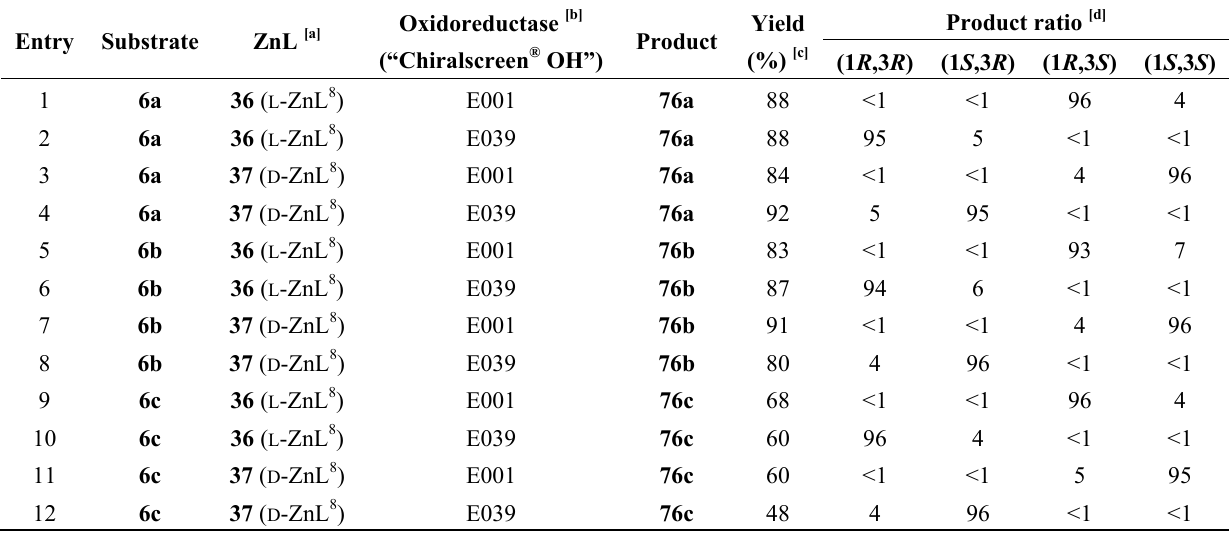
Table 10. Results for the one-pot chemoenzymatic synthesis of chiral 1,3-diols 76a – c in aqueous solvent by the combined use of enantioselective aldol reactions catalyzed by chiral Zn 2+ complexes and enantioselective reduction using “Chiralscreen ®